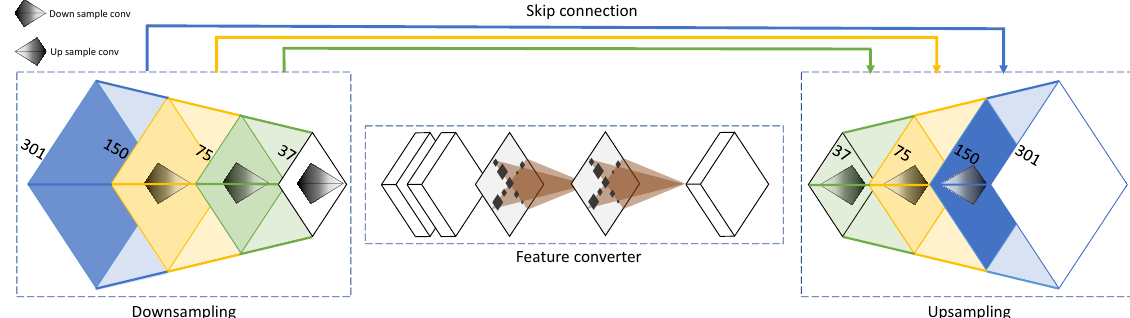
Figure 5. The network structure of the